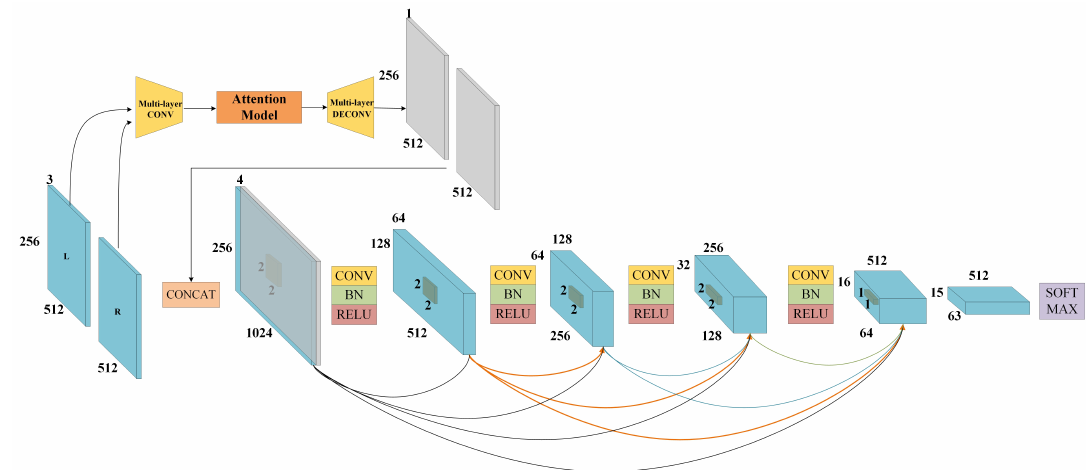
Figure 6. Discriminator Network.